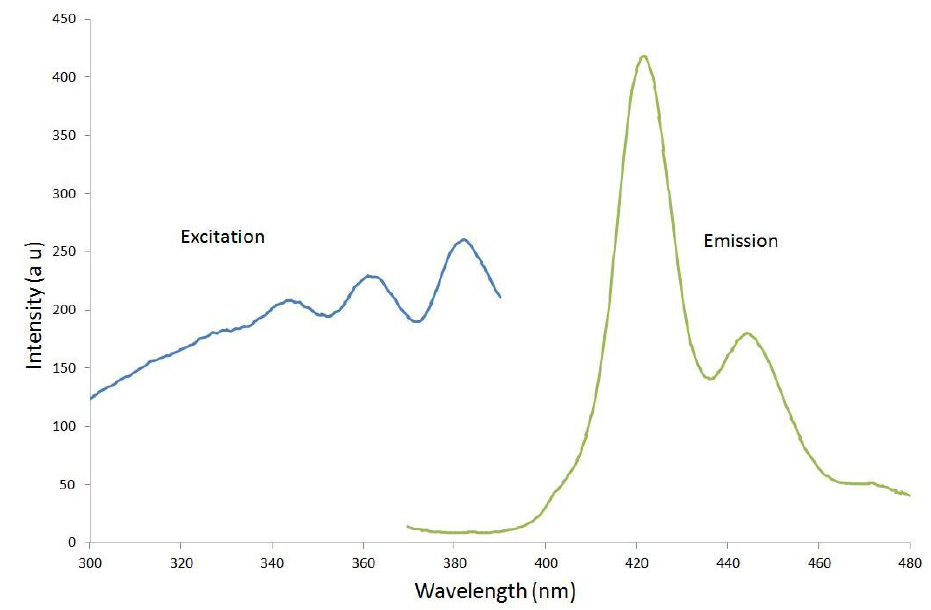
Figure 5. Excitation and emission spectra are shown from left to right for anthracene fibers in quartz. The emission spectral profile agrees with the data for microcrystalline anthracene from Ref